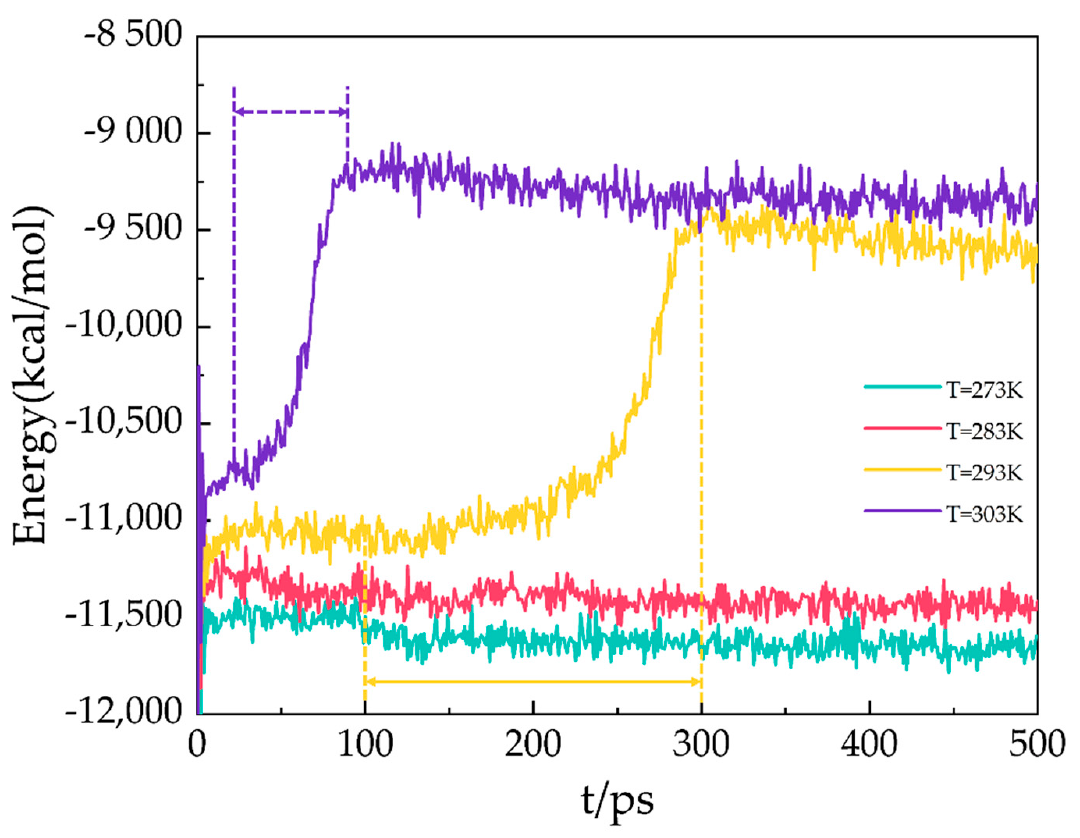
Figure 7. Potential energy for A3 models at P = 2 MPa and T = 273 K, 283 K, 293 K, and 303 K.